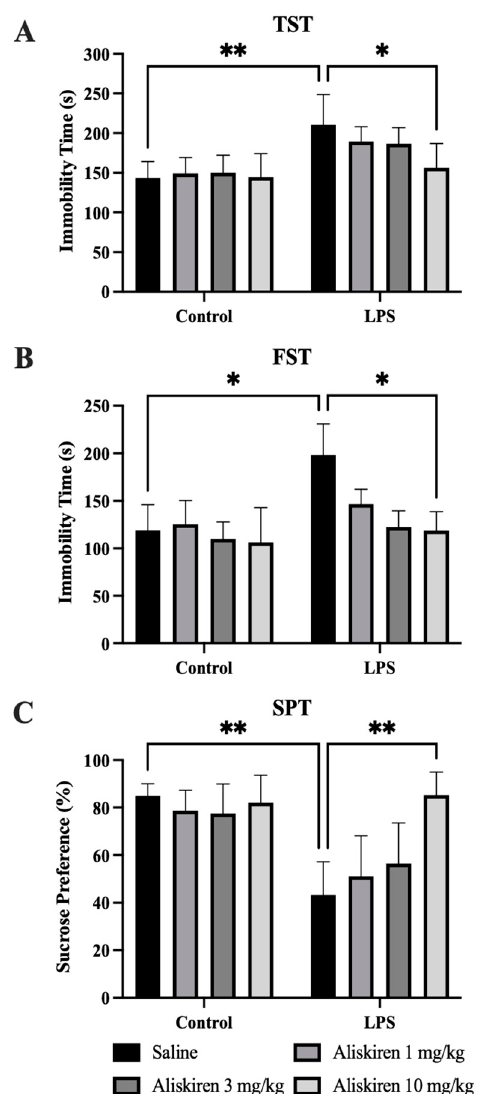
Figure 3. Assessment of Antidepressant-like Effect of Aliskiren in Mice. ( A ) The effects of Aliskiren on immobility time in TST. ( B ) The effects of Aliskiren on immobility time in FST. ( C ) The effects of Aliskiren on sucrose preference % in SPT. n ≥ 6 mice/group. * p < 0.05; ** p < 0.01.